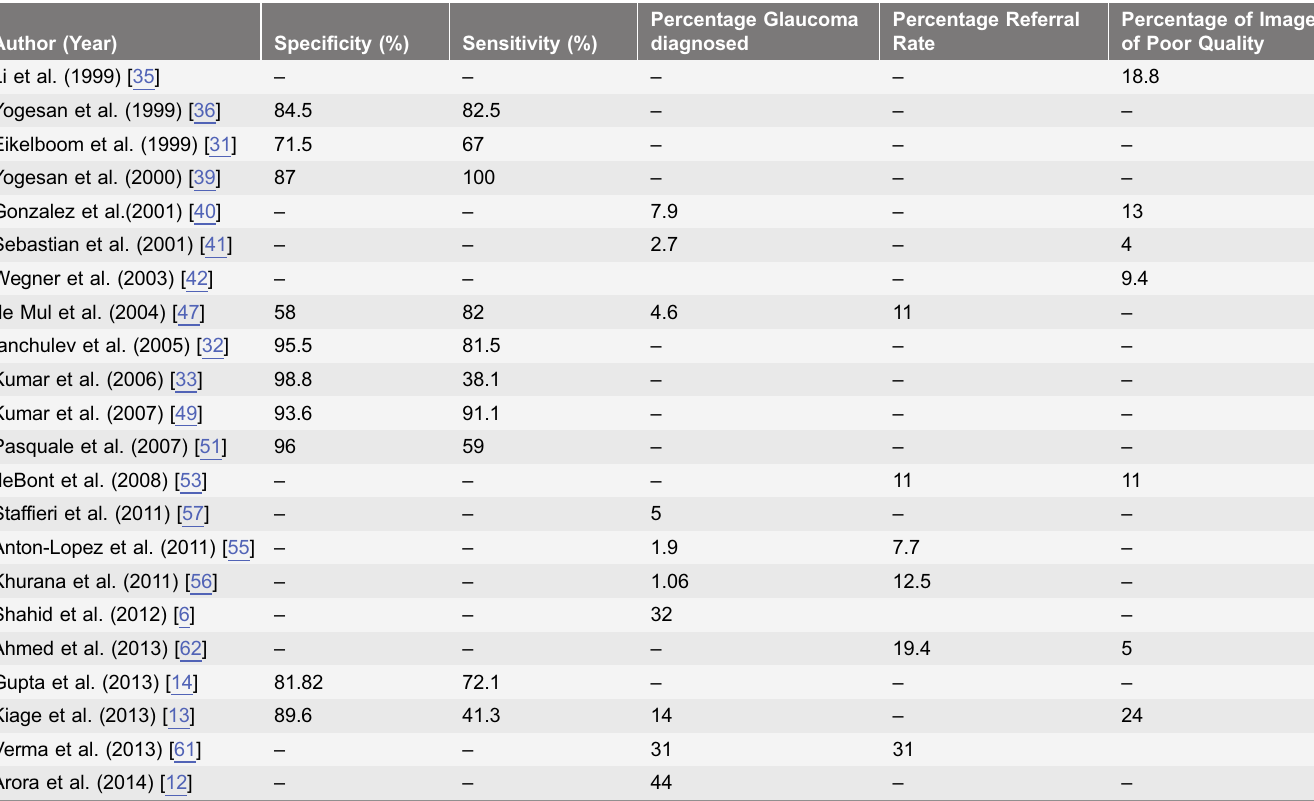
Table 5. Study relevant outcome